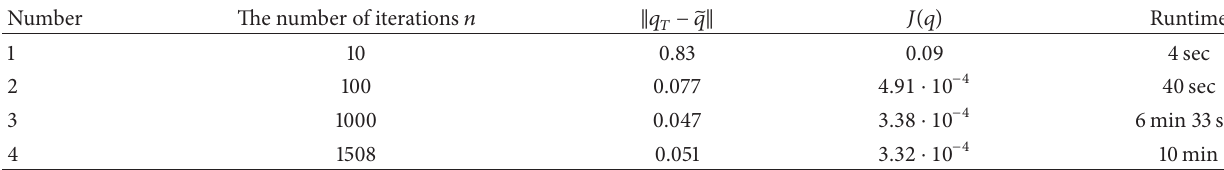
Table 2: Calculation results in the case of noise within 1% 𝜀 = 0.01 .